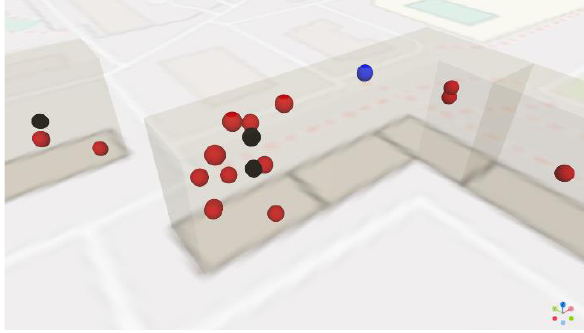
Figure 7 . The most problematic part of the building No.